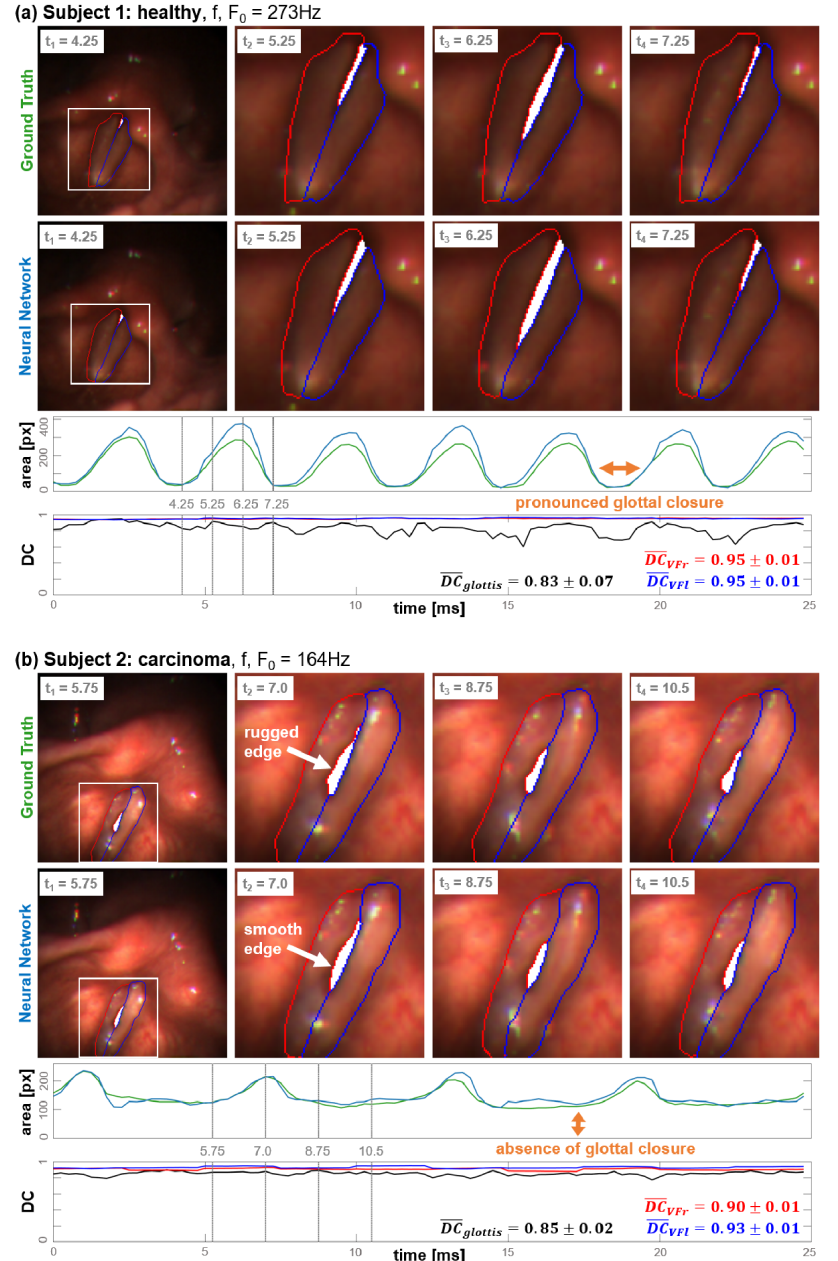
Fig 6. Accuracy of glottal area segmentation over time. (a) Healthy subject. (b) Pathologic subject (carcinoma). From top down: HSV frames extracted from a single oscillation cycle. Upper row: GT segmentations, Lower row: NN segmentations. The upper graph shows the glottal area waveforms (green: GT, blue: NN) while the lower one represents the Dice Coefficients which are computed for each class individually (red/blue: right/left vocal fold , black: glottis